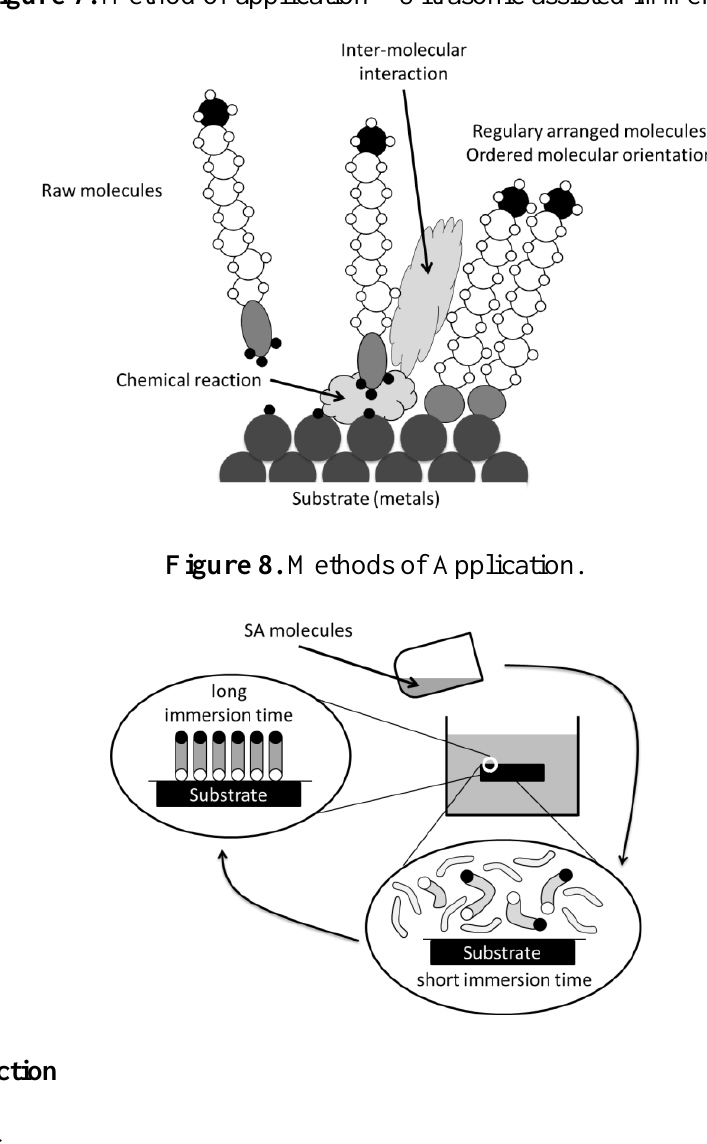
Figure 7. Method of application—Ultrasonic assisted immersion.